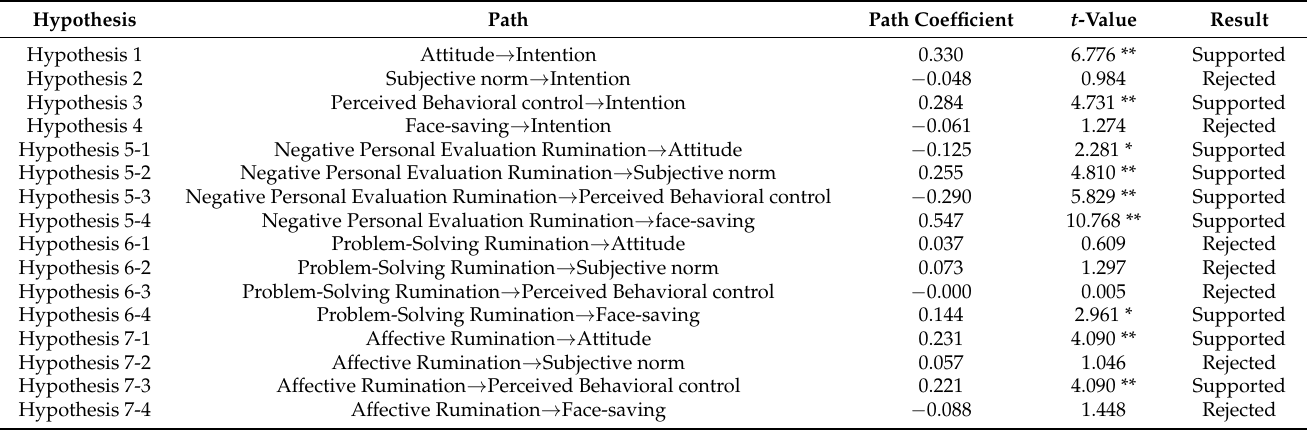
Table 5. Exploratory Factor Analysis of the Modified Theory of Planned